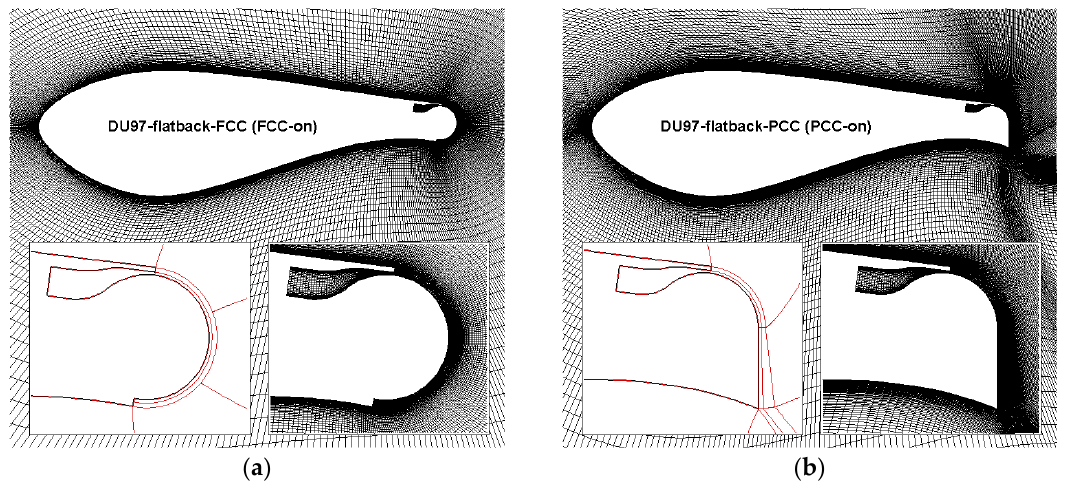
Figure 8. Grids of the FCC-on and PCC-on airfoils: ( a ) FCC-on; ( b ) PCC-on.